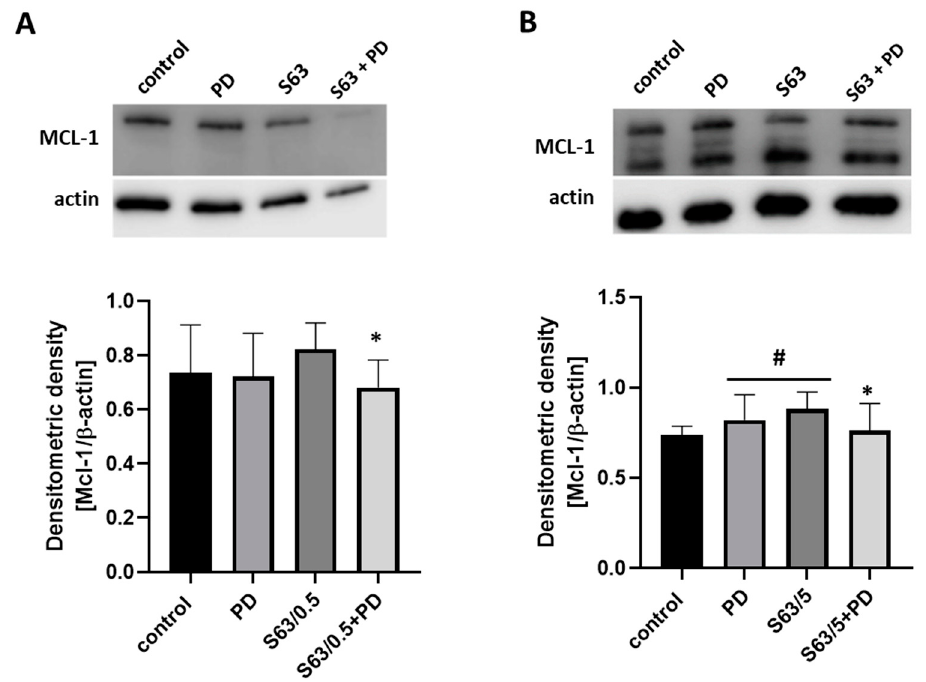
Figure 9. Expression of MCL-1 protein in HL-60 (panel A ) and ML-1 (panel B ) cells after treatment with S63845 (S63) and PD98059 (PD) alone and in combination for 24 h, as detected by Western blotting. Relative levels of MCL-1 protein were quantified by densitometry and normalized to β -actin. Designations 0.5 and 5 indicate the S63845 concentrations (µM). The results are expressed as the mean values ± SD of three independent experiments. Values significantly different ( p < 0.05) according to one-way ANOVA are designated by * compared to S63845—single treated group; # compared to the corresponding control.